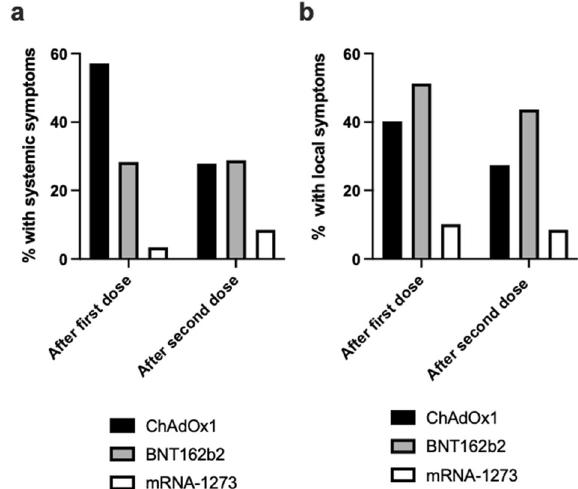
Fig. 1 Proportions of participants experiencing systemic or local reactive symptoms after receiving fi rst and second doses of ChAdOx1, BNT162b2, and mRNA-1273 vaccines. Panel a shows systemic symptoms are more common with ChAdOx1 vaccine following fi rst dose. Panel b shows local symptoms are more common with BNT162b2 vaccine following second